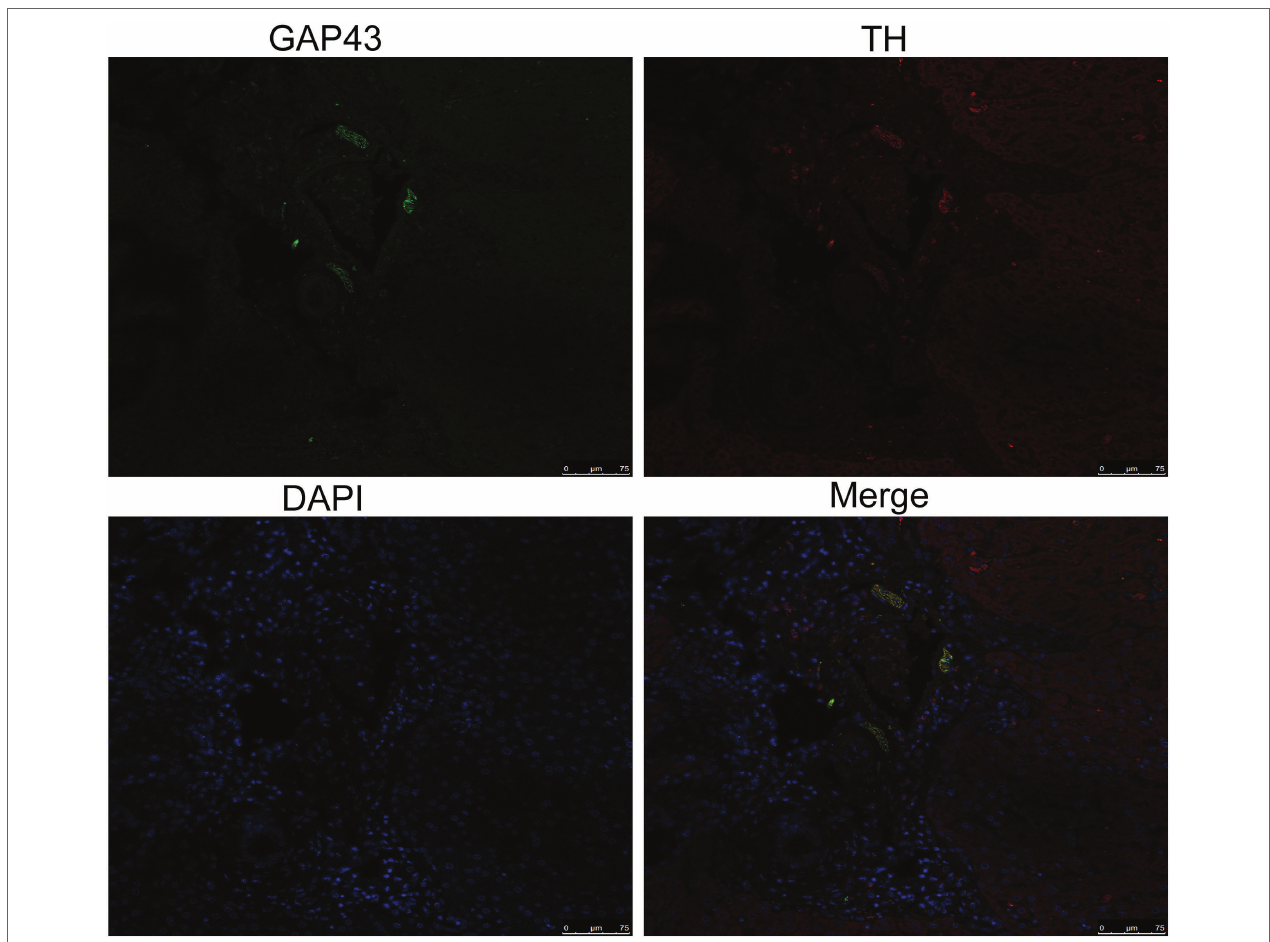
FIGURE 4 | Identification of sympathetic nerves in the liver by confocal laser scanning microscopy. GAP43/TH colocalization indicated hyperplastic sympathetic nerves in the livers of insomnia rats (scale bar: 75 μ m).